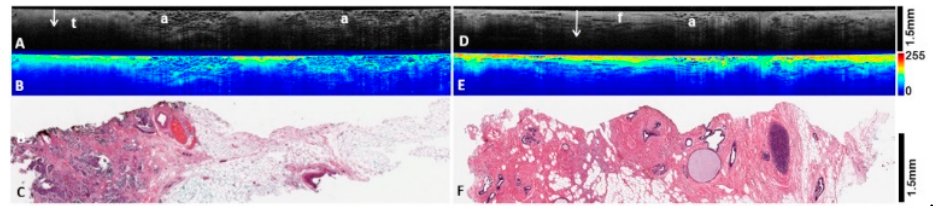
Figure 4. OCT image and heatmap analysis of invasive tumor (left column, A – C ) and normal breast tissue (right column, D – F ) from the same patient. ( A ): OCT B scans of invasive tumor (t) and surrounding adipose tissue (a). The tumors are characterized by reduced light PD (arrow) and dull texture. ( B ): Heatmap representation of corresponding OCT image above, showing lower levels of scatter by the tumor, manifested in mostly yellow hues. ( C ): Corresponding histology of invasive ductal carcinomas, intermediate grade. ( D ): OCT B scans of normal breast tissue demonstrating fibrous stroma (f) and adipose tissue (a). The arrow shows increased light PD compared with tumors. ( E ): Heatmap representation of corresponding OCT image above. Note greater presence of warm colors and more homogenous light scattering pattern within benign fibrous tissue compared with tumors. ( F ): Corresponding histology of benign breast tissue. Figure 4F also shows dilated ducts and usual ductal hyperplasia.